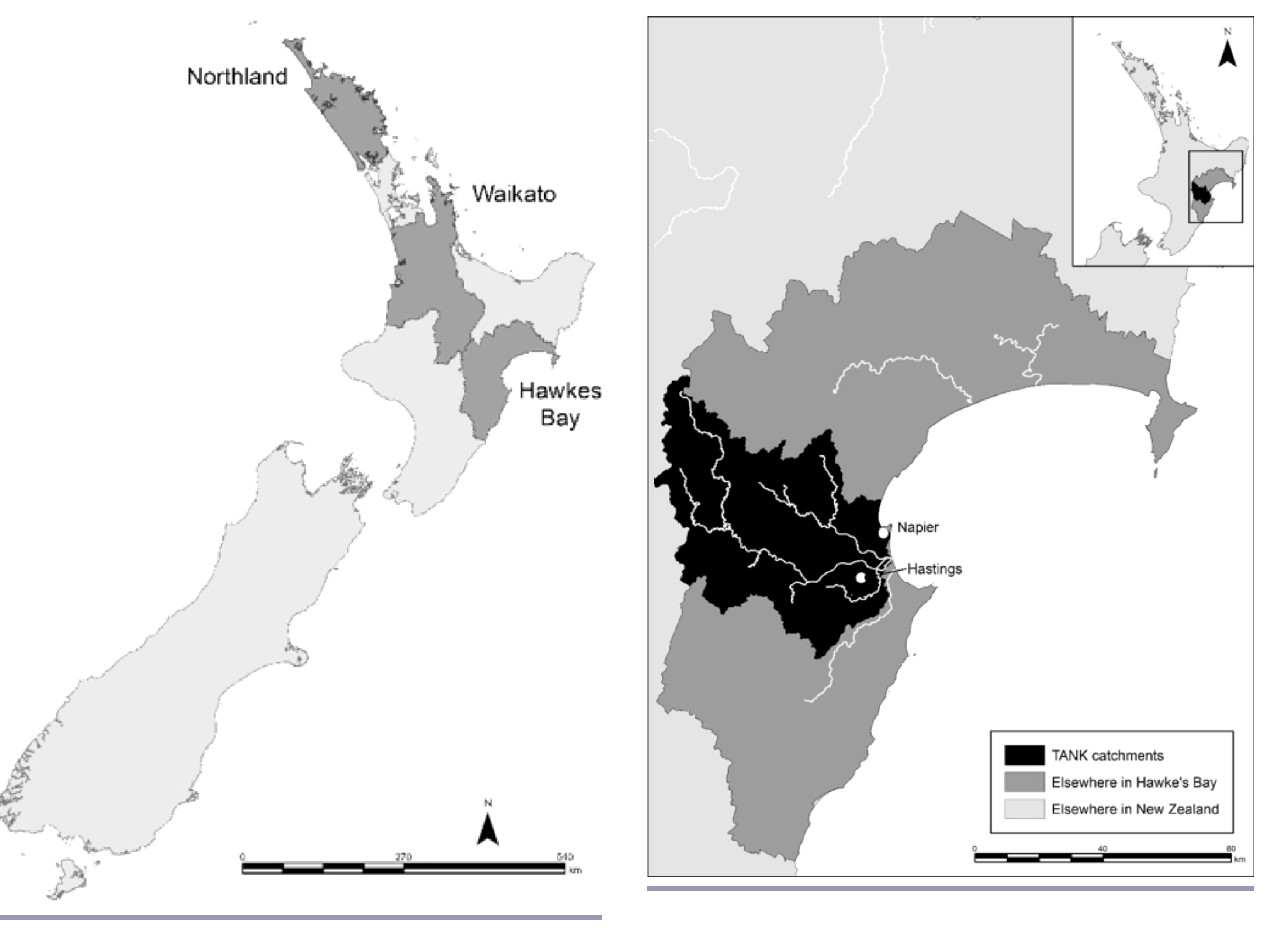
Fig. 1 . New Zealand. The three regions under study are highlighted.